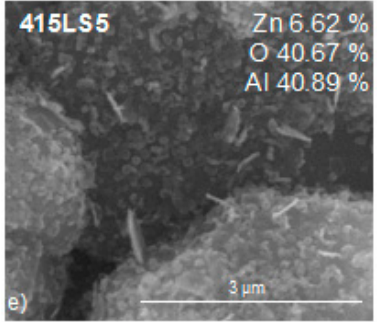
Figure 2. Low magnification SEM micrographs of the different thin ZnO films supported on Al 2 O 3 substrates (big grains correspond to alumina). EDX results are indicated as insets to each micrograph. Panels ( a – e ) correspond to films obtained employing the five different thermal treatments implemented. Refer to Table 1 for full details.